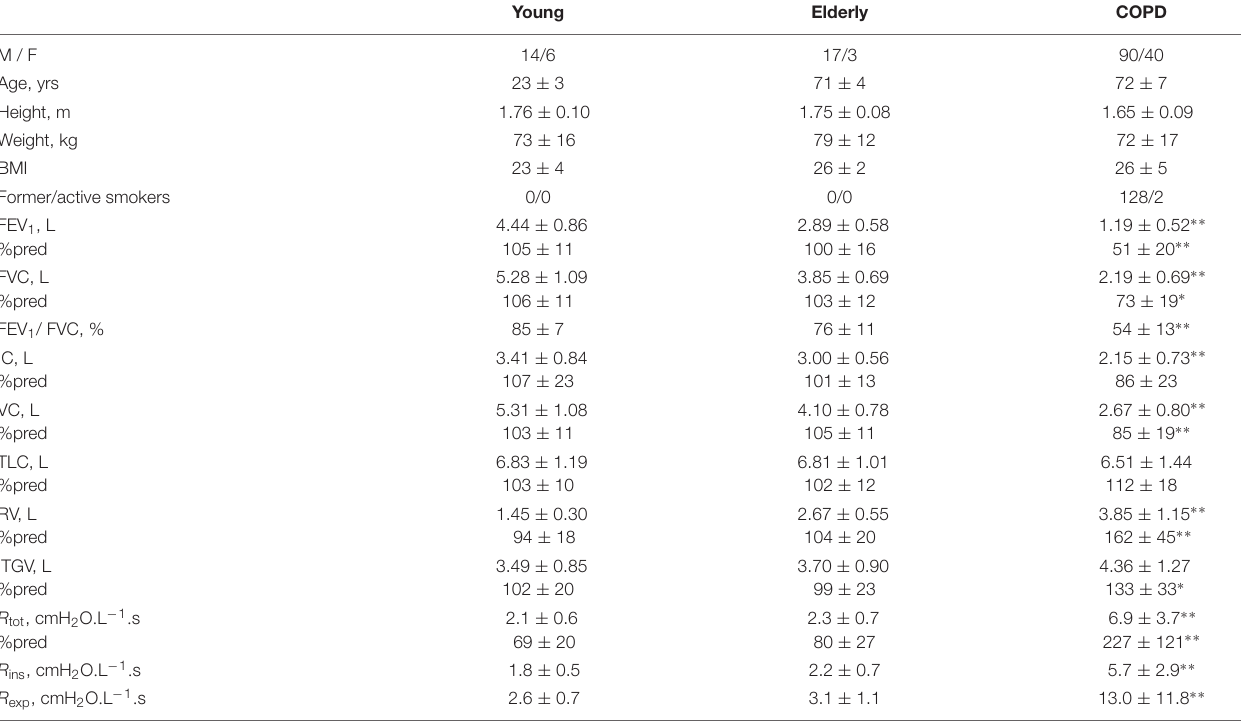
TABLE 1 | Anthropometric characteristics, spirometric and plethysmographic parameters of healthy subjects and COPD patients. Young Elderly